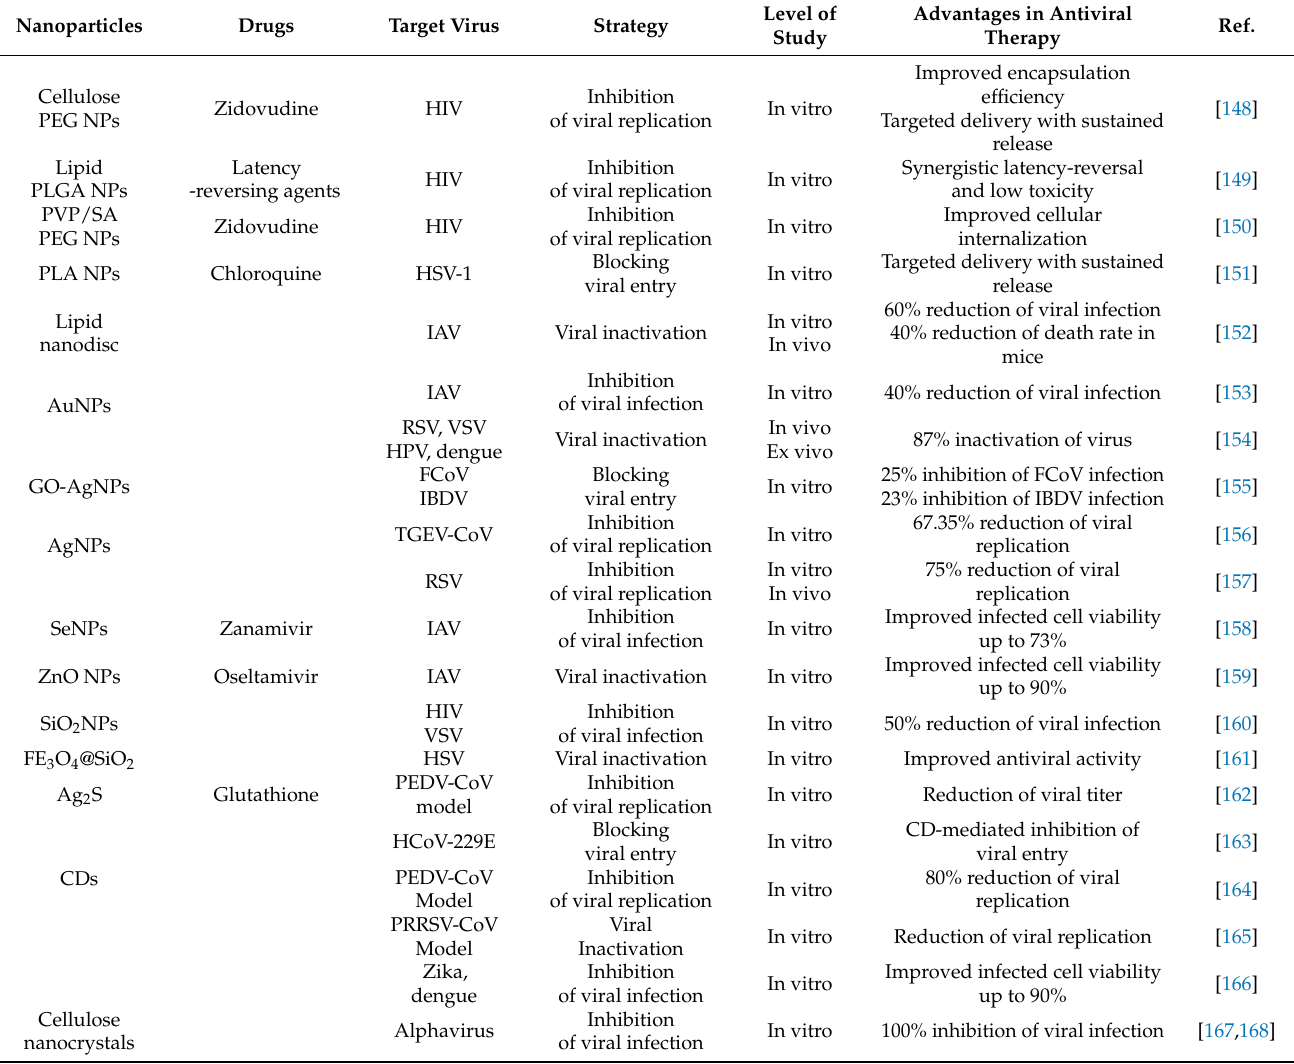
Table 2. Nanomaterials for antiviral